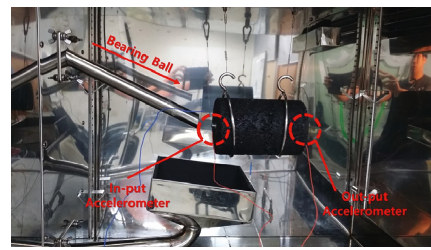
Figure 4: Setup of IRT.